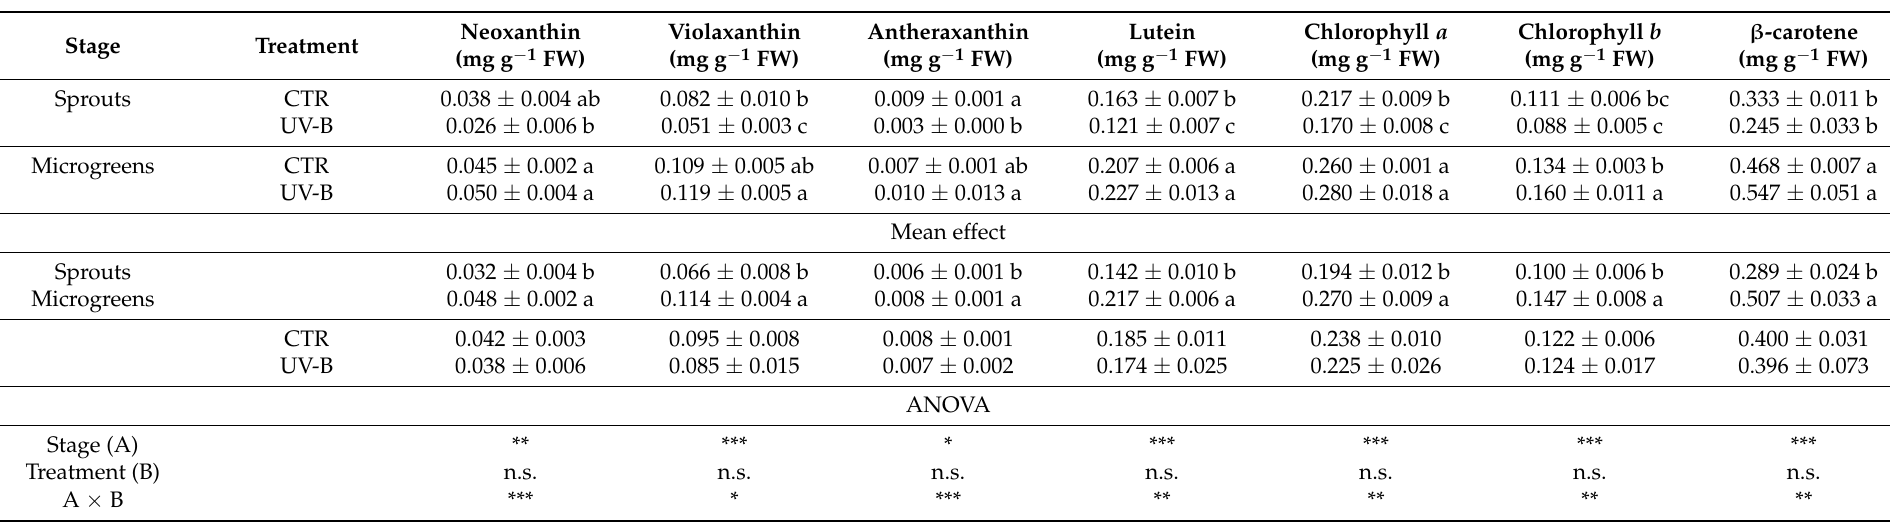
Table 3. Concentration (mg g − 1 FW) of neoxanthin, violaxanthin, antheraxanthin, lutein, chlorophyll a , chlorophyll b , and β -carotene in flaxseed sprouts